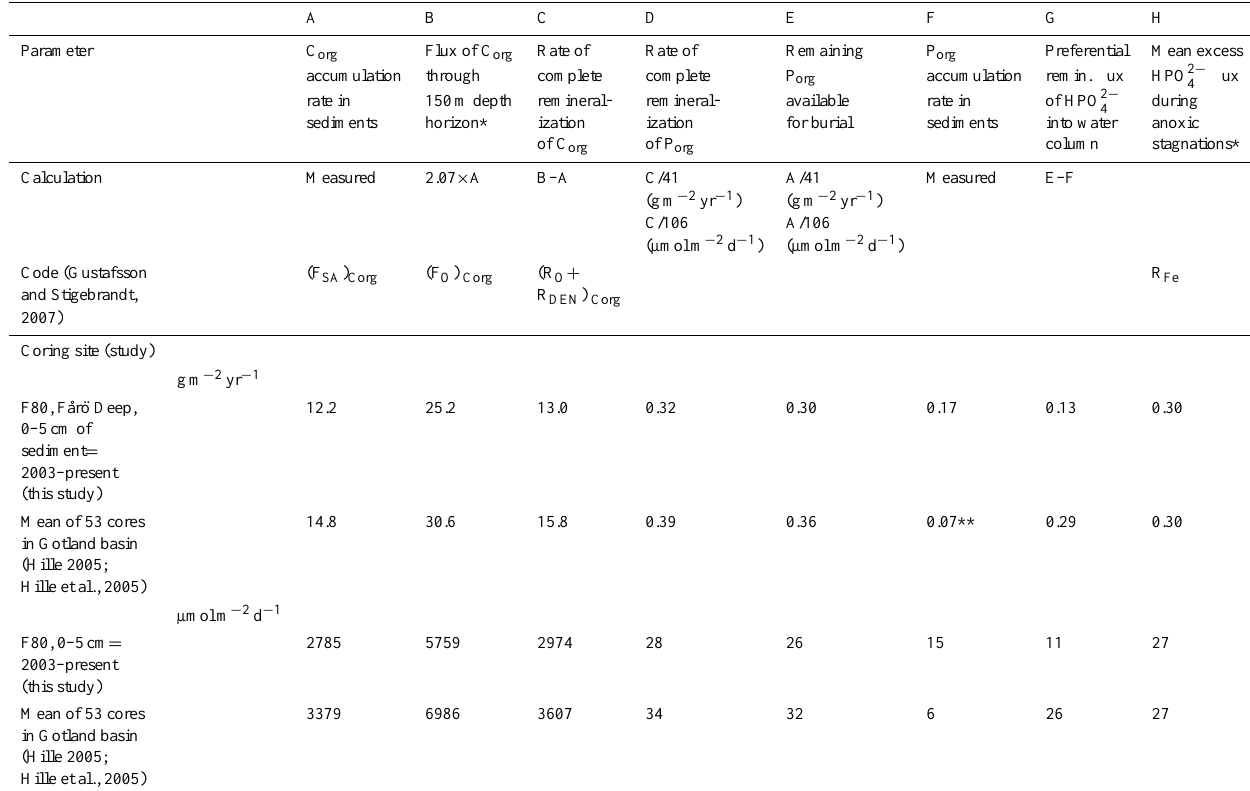
Table 1. Summary of carbon and phosphorus fluxes in deep basins of the